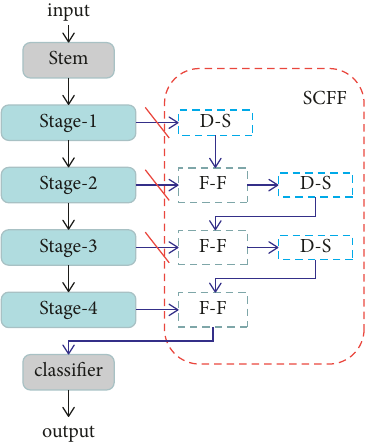
Figure 3: Gradient blocking in SCFF.